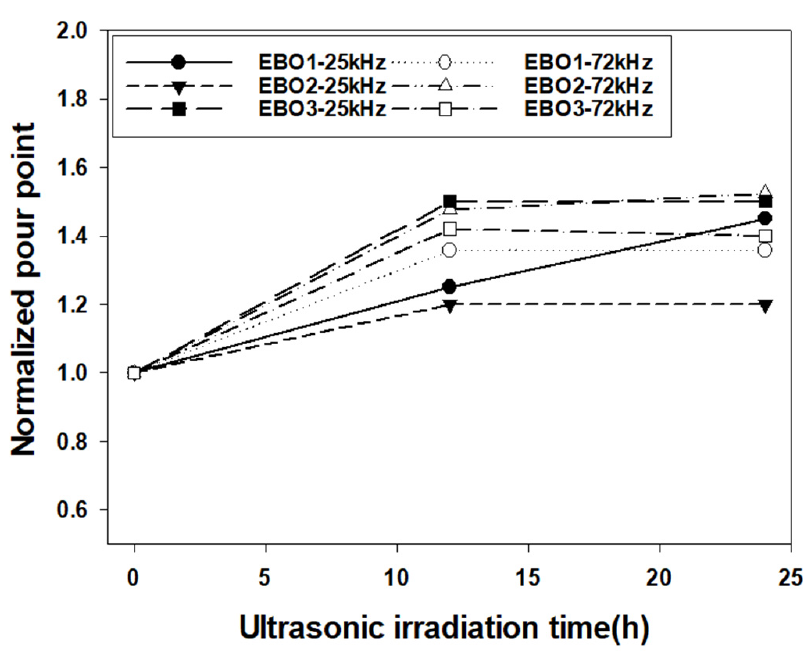
Figure 5. Variation in pour point as a function of ultrasonic irradiation time.